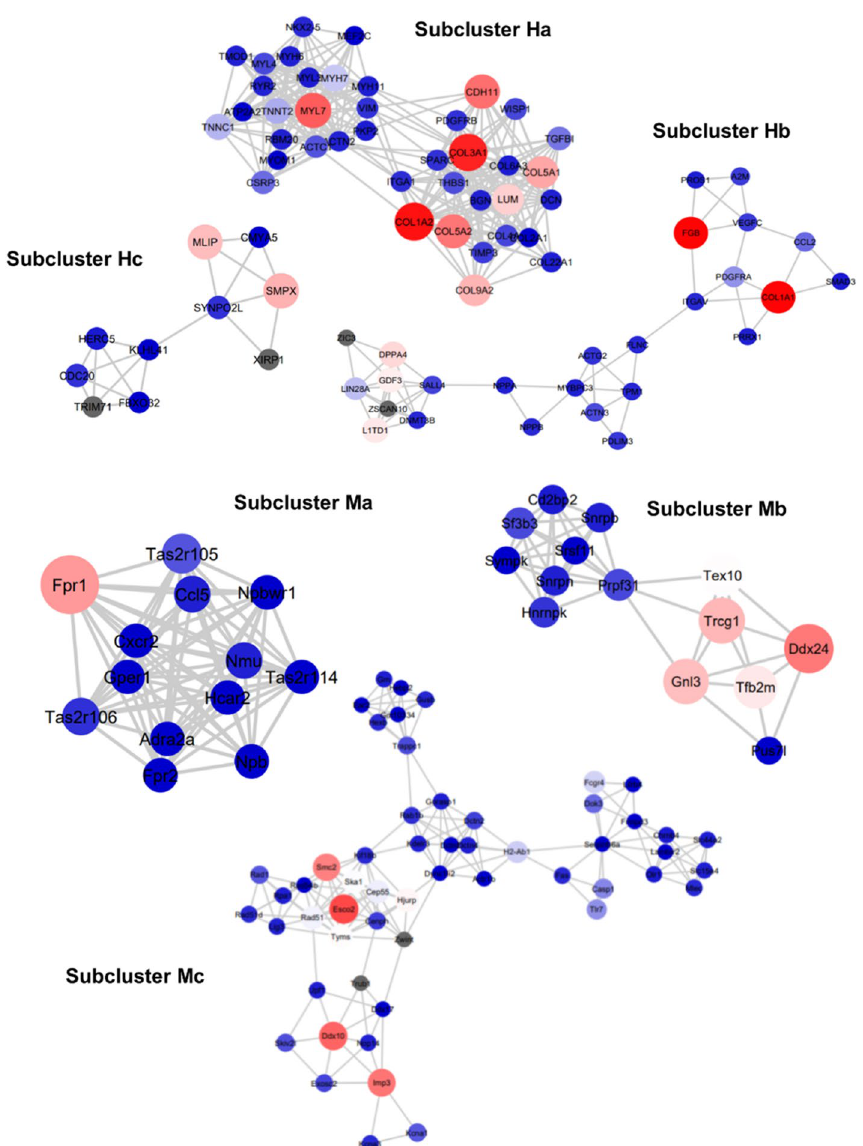
the original PPI networks are present. The colour and size of the node reflects the connection degree, with the redder, larger nodes having a higher connection degree, while the bluer, smaller nodes having a lower connection degree. a Subclusters Ha (Human a), Hb (Human b), and Hc